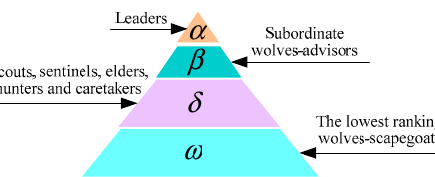
Figure 5. A population hierarchy of the GWO algorithm.